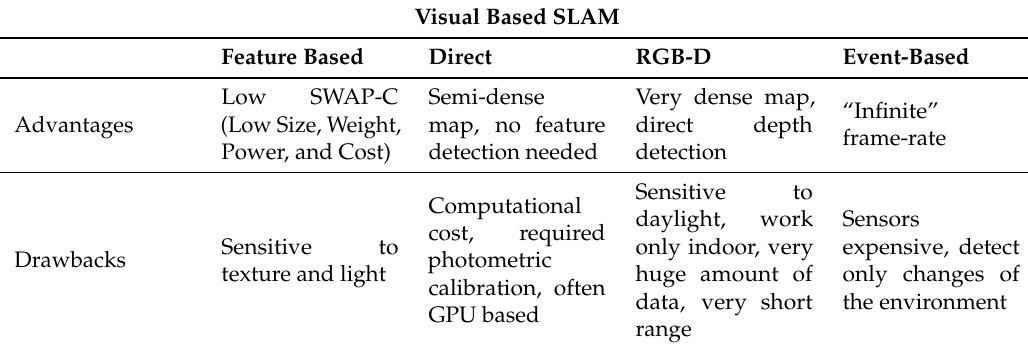
Table 1. Summary of visual based SLAM’s advantages and